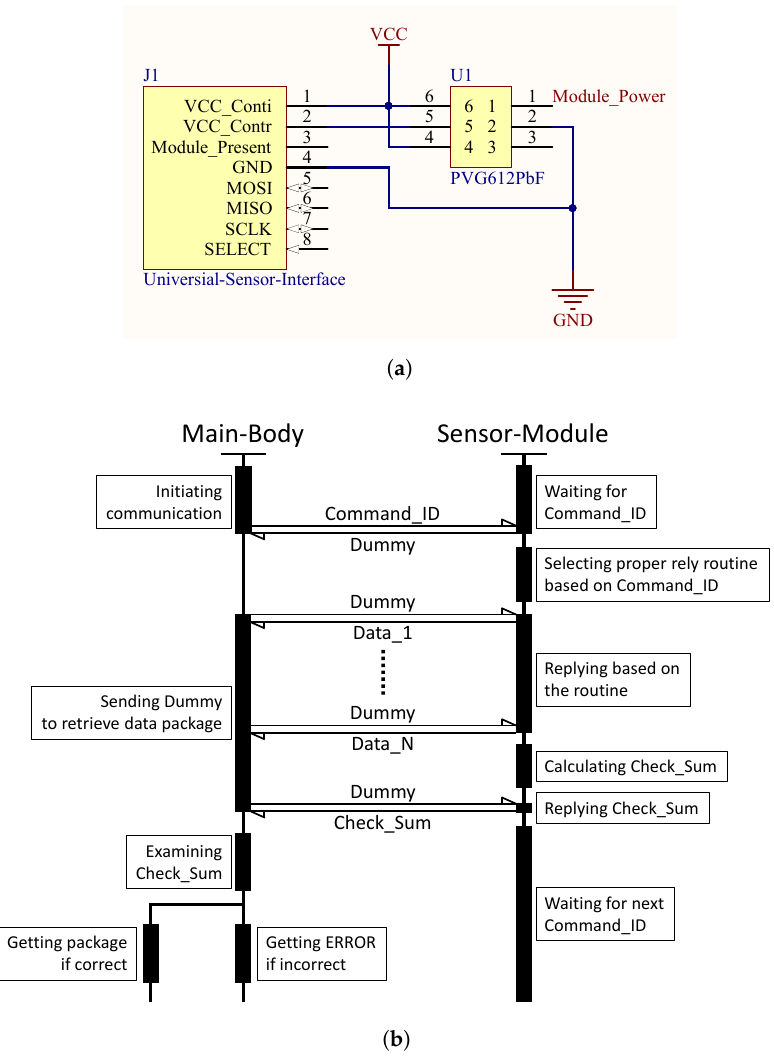
Figure 3. Schematic and communication protocol of the USI. ( a ) schematic of a USI on Main-Body; ( b ) timing diagram of the SPI based communication